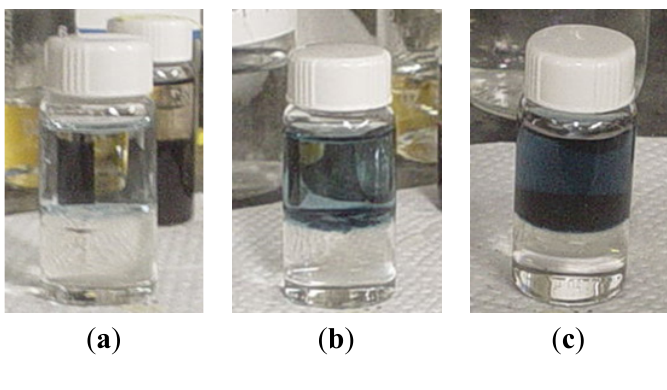
Figure 6. Interfacial polymerization process with 0.32 M of aniline in chloroform (bottom layer) interfacing 0.08 M of ammonium peroxydisulfate (top layer): ( a ) 1 min, ( b ) 5 min, and ( c ) 10 min of the reaction time after the reaction